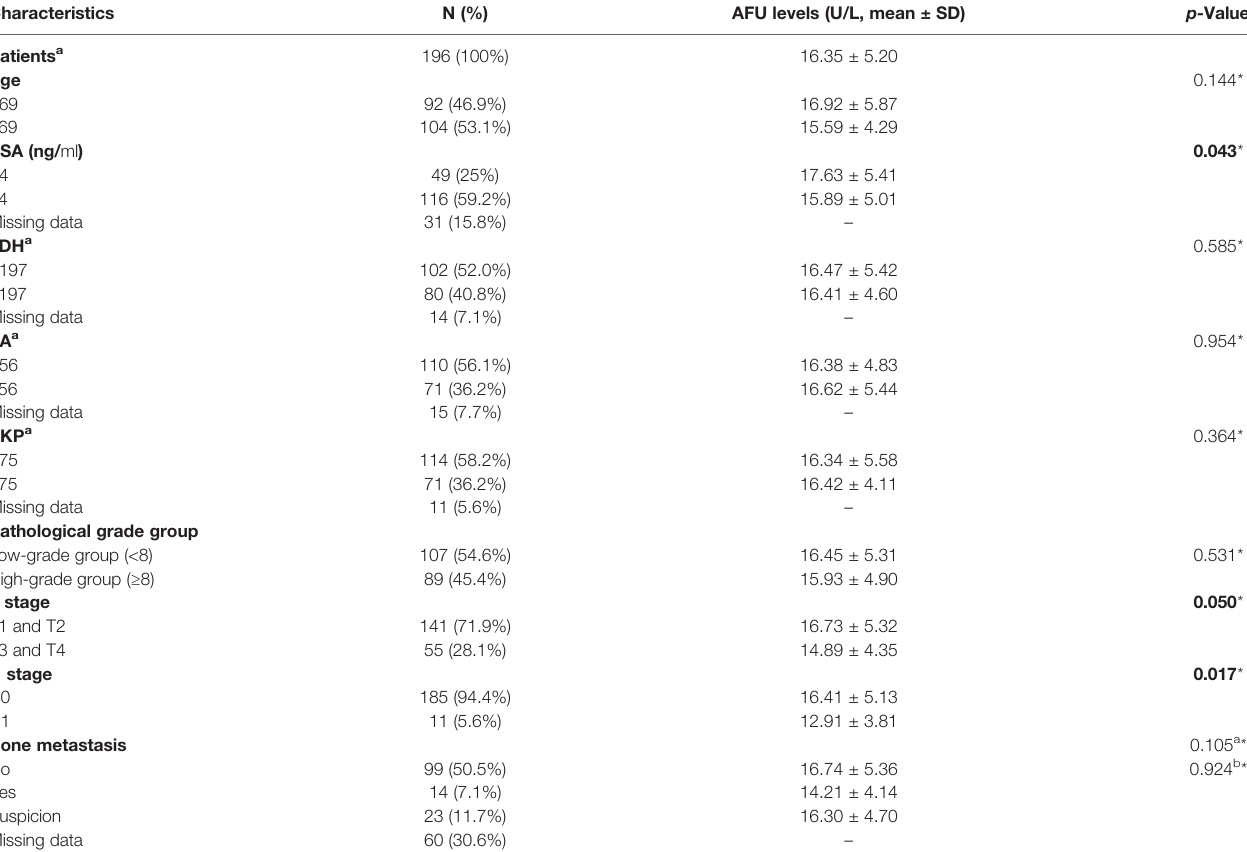
TABLE 2 | Correlations between preoperative AFU levels and clinicopathological parameters of PCa patients.